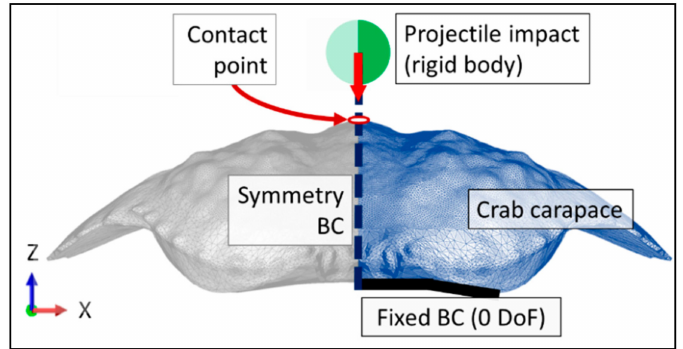
Figure 5. Carapace impact and boundary conditions (denoted by BC)